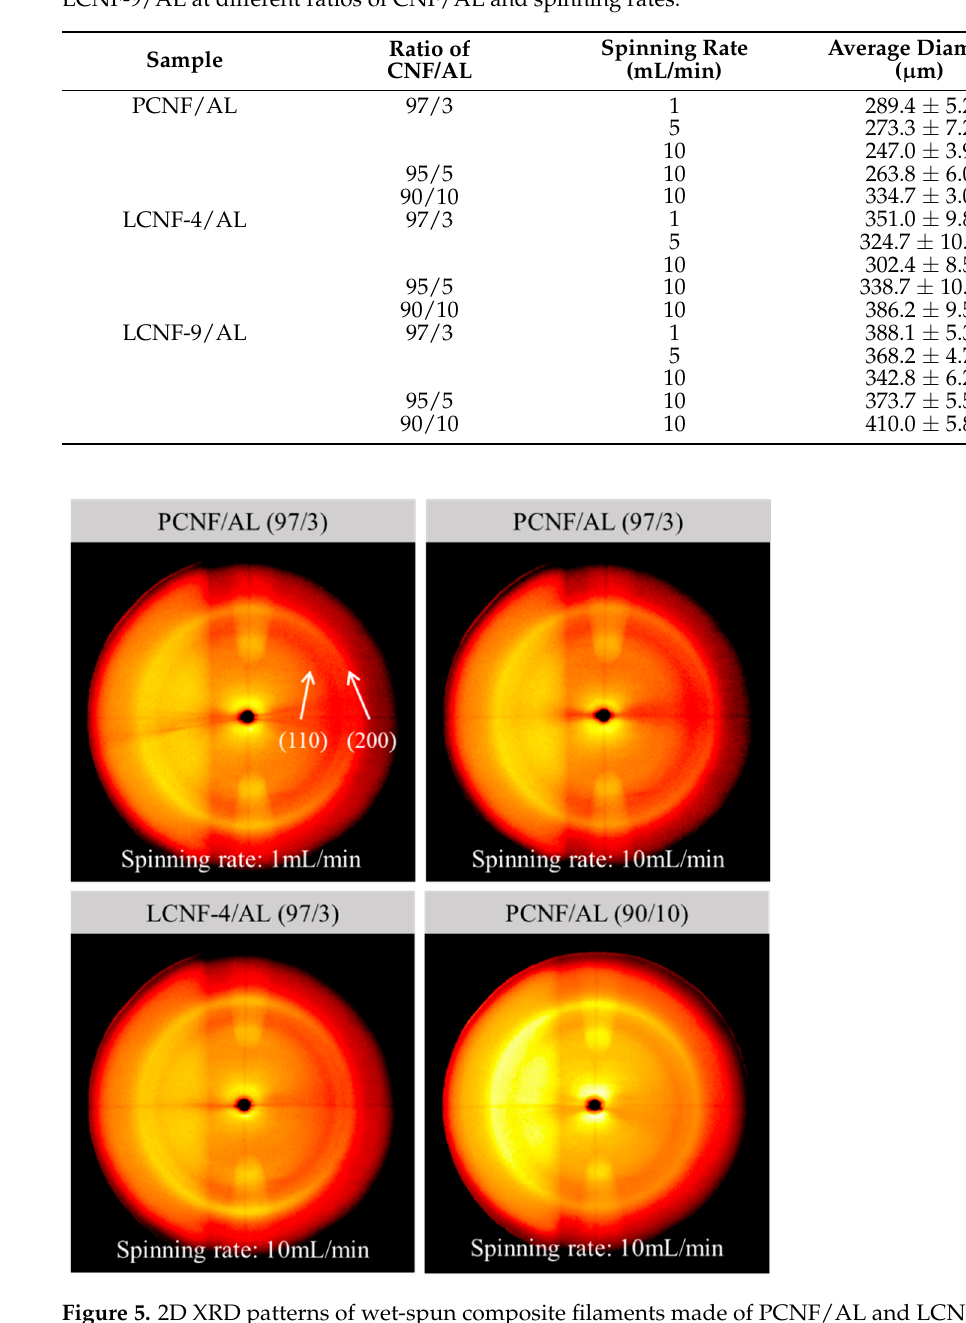
Figure 6. Azimuthal profiles of the (200) reflections from 2D XRD patterns of the wet-spun compo- site filaments made of PCNF/AL and LCNF-4/AL with different AL contents and spinning rates. Note: orientation index (OI).